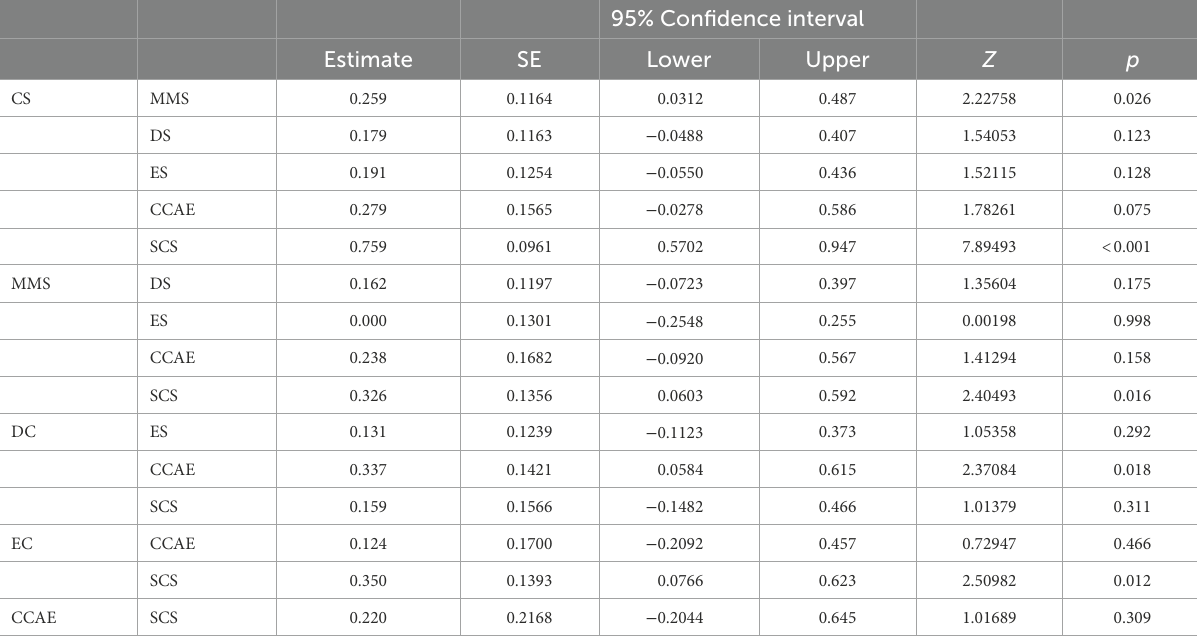
TABLE 3 Confirmatory factor analysis factor covariances summary.